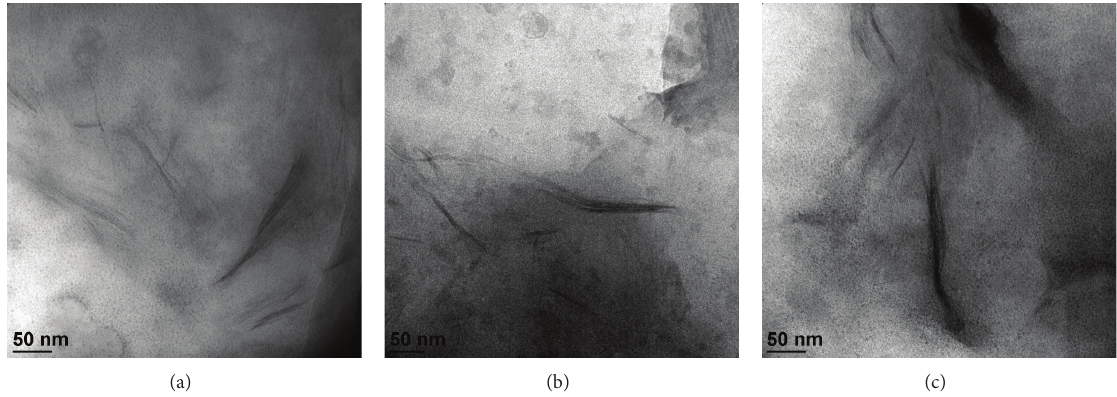
Figure 4: TEM micrographs of PCHO/clay nanocomposites, PCHO/M1, PCHO/M3, and PCHO/M5.